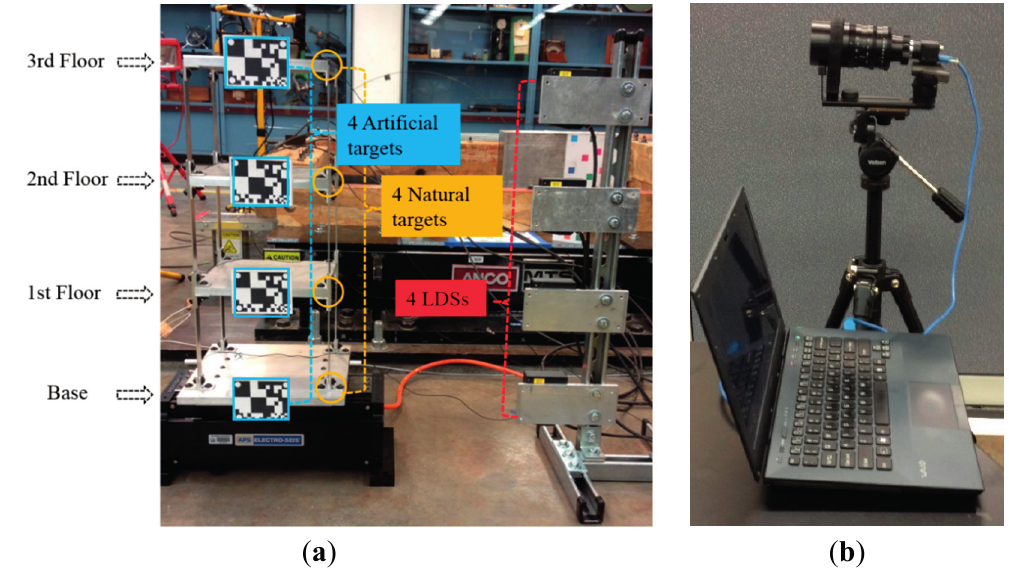
Figure 5. Laboratory test: ( a ) Shaking table test setup; ( b ) Vision sensor system